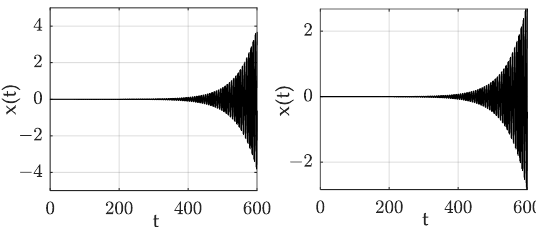
Figure 4. Response of point B, with F=0 ( left ) and F=1 ( right ).